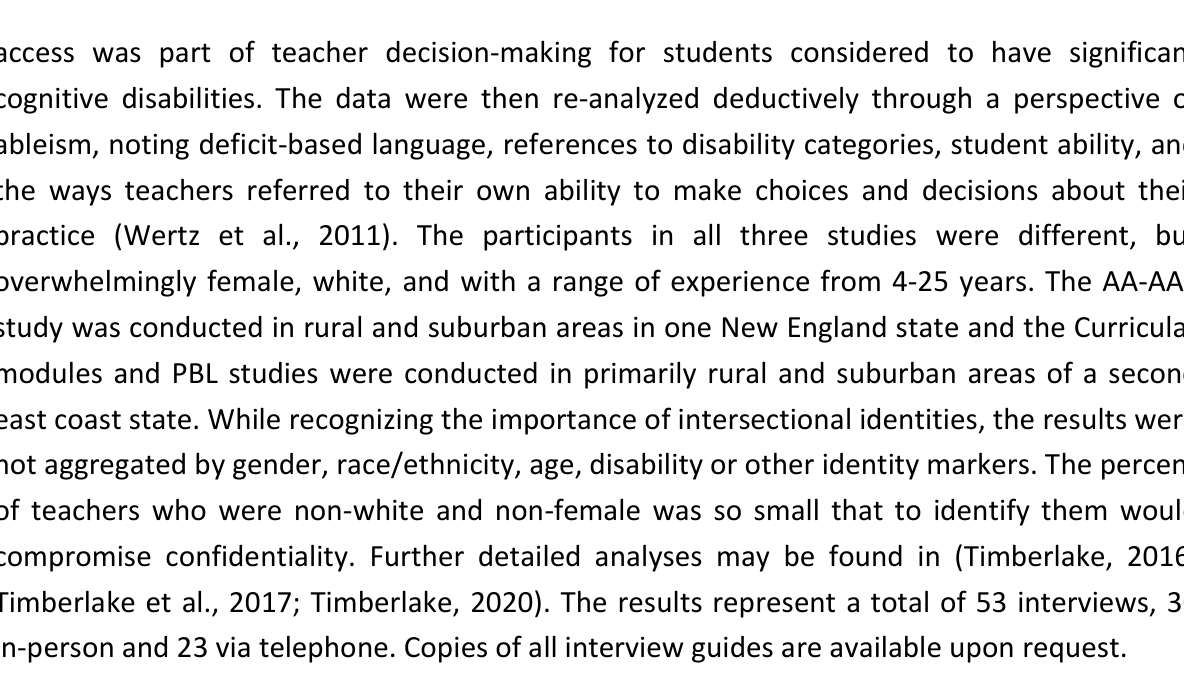
Table 1: Three studies of academic access and disability analyzed for ableism Educational initiative collected